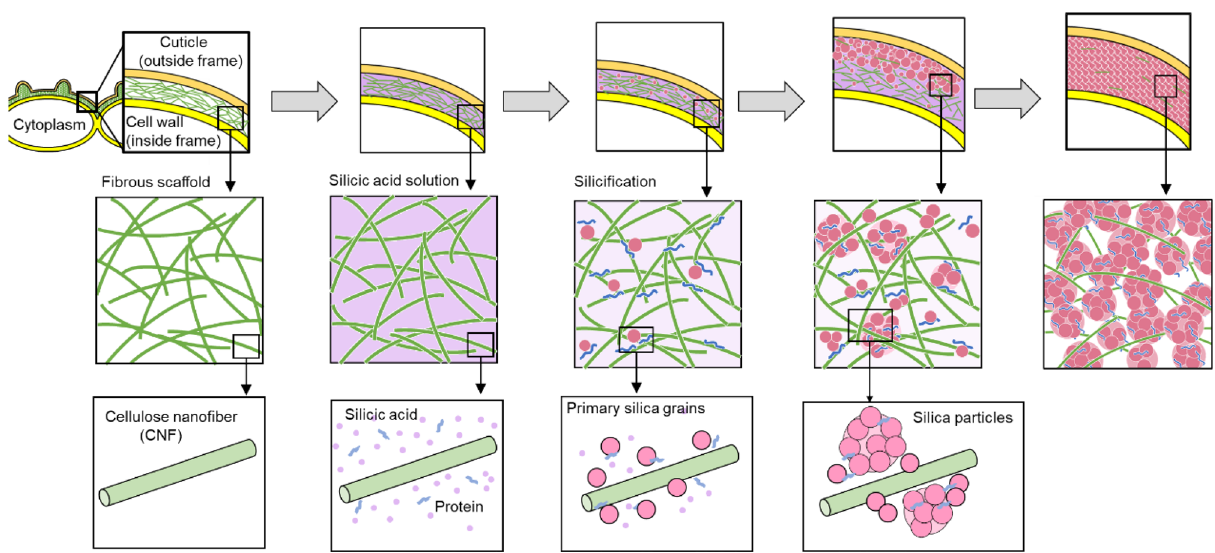
Figure 7. A schematic illustration of the silica accumulation process with a scaffold of CNFs. A scaffold of CNFs is initially formed as a spatial template for silicification between the cuticle layer and the epidermal cell wall. Silicic acid in the CNF matrix is polymerized with the molecular template and forms silica particles. The silica particles filled up the space between the cuticle layer and the epidermal cell wall with the CNF